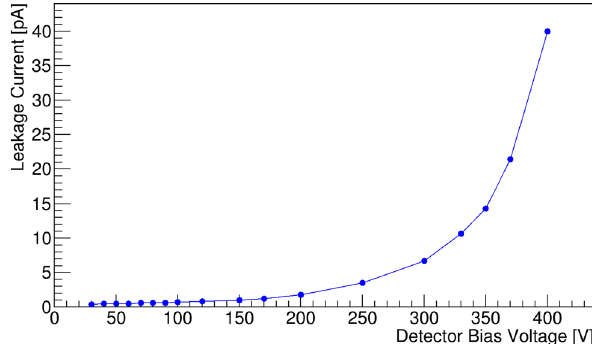
Fig. 8 Measured leakage current as a function of bias voltage at 79 K fordetectorUSD-W06.Lowleakagecurrent( ∼ 0.5pA)atfulldepletion voltage (60 V) shows the good quality of a-Ge contacts